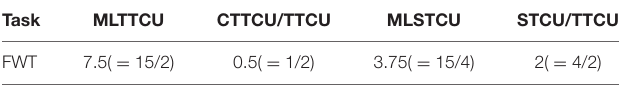
TABLE 2 | Calculated scores for the coding sample (ID: 101) on free writing